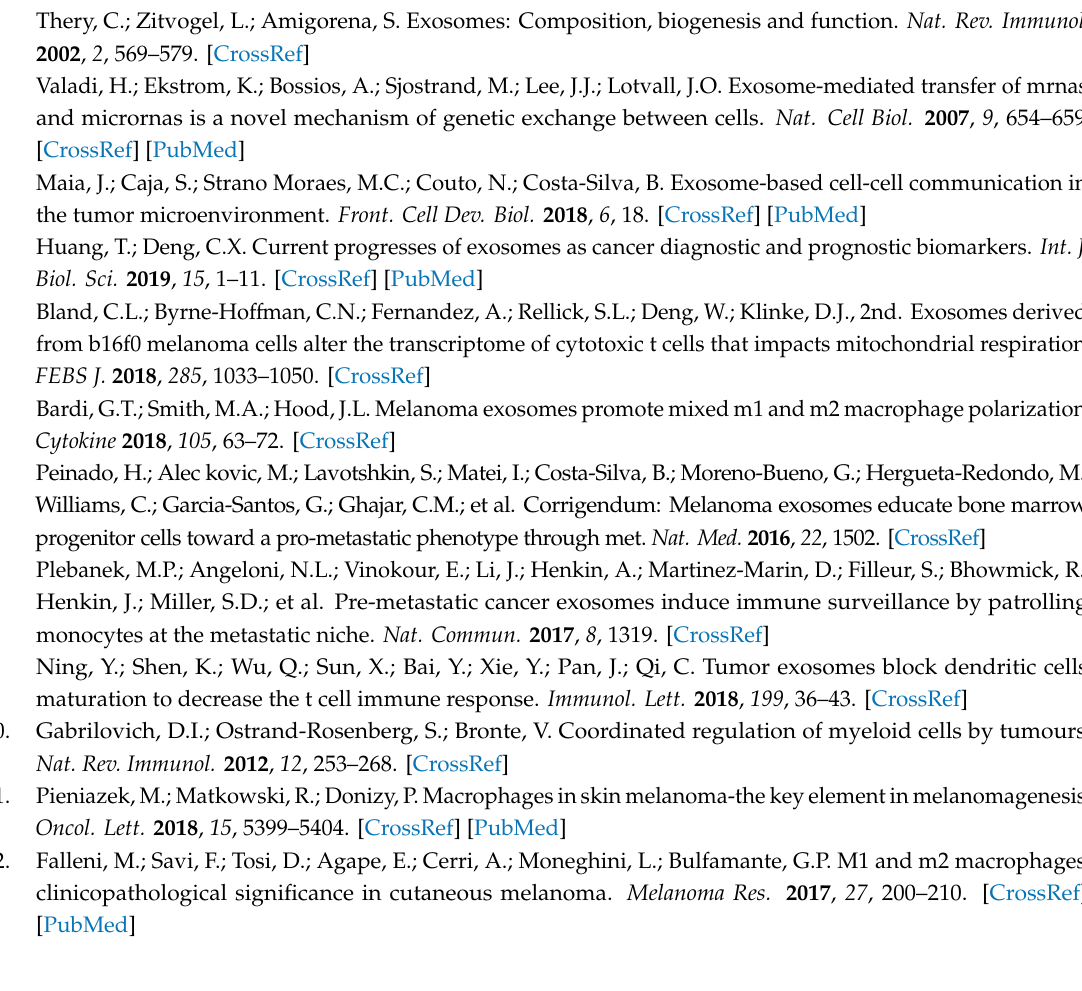
Figure S1: Induction of macrophages gene expression by melanoma-derived exosomes; Figure S2: miR-125b-5p expression is increased in melanoma cells; Figure S3: IL-6, IL-8, VEGFa, and TNF α expression is not induced by miR-125b-5p